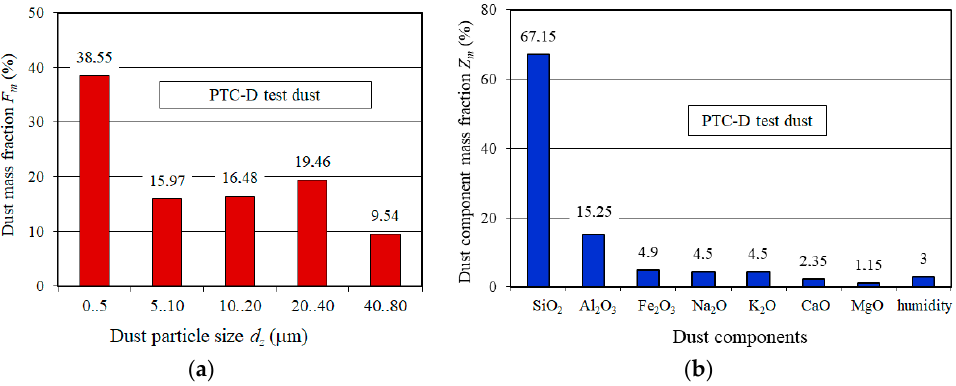
Figure 3. PTC-D test dust: ( a ) dust mass fraction, ( b ) dust component mass fraction [52].